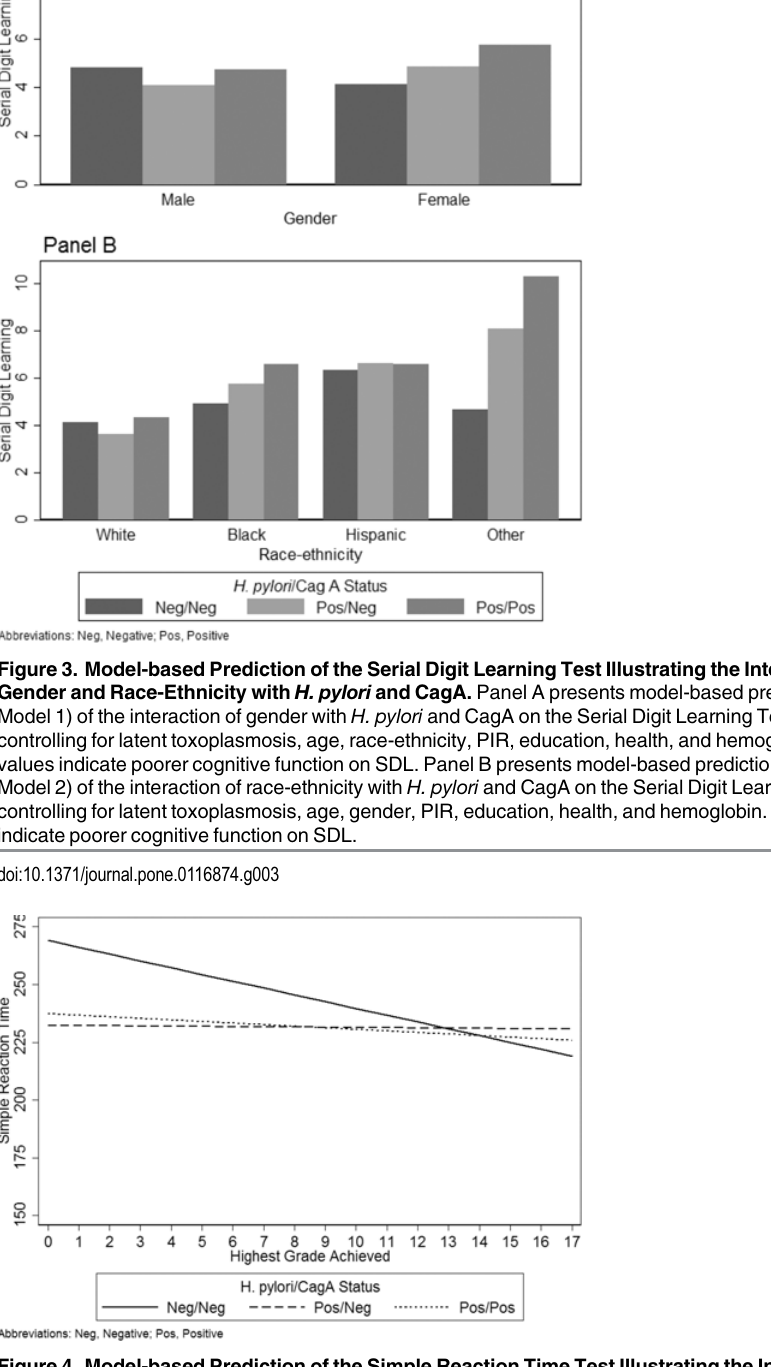
Figure 4. Model-based Prediction of the Simple Reaction Time Test Illustrating the Interaction of Highest Grade Achieved with H. pylori and CagA. Data are model-based predictions of the interaction of education with H. pylori and CagA on the Simple Reaction Time Test (SRT) controlling for latent toxoplasmosis, age, gender, race-ethnicity, PIR, health, and hemoglobin. Higher SRT values indicate poorer cognitive function.